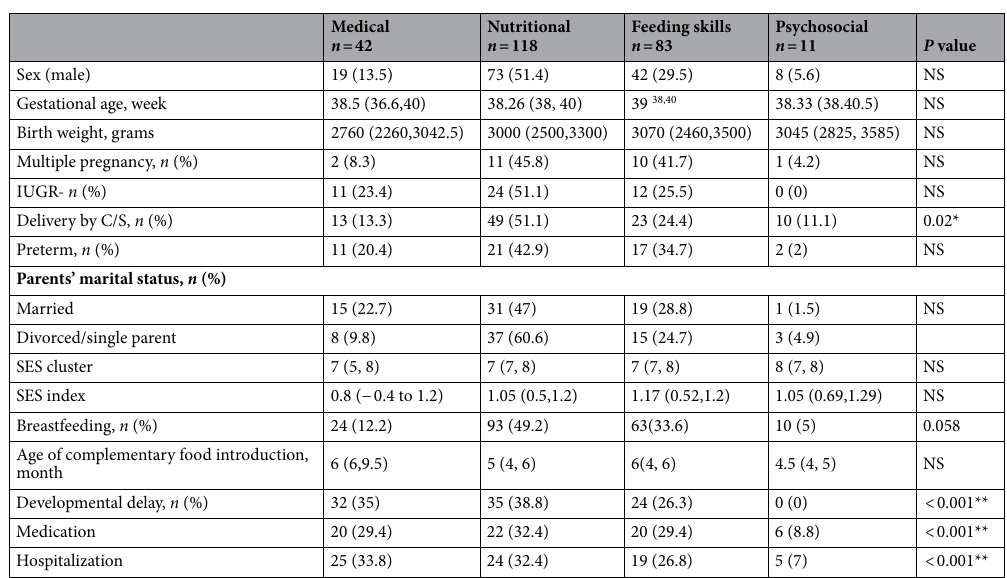
Table 3. Factors associated with feeding disorders according to feeding disorder type. The data are expressed as median and interquartile range for continuous variables and n (%) for categorical variables. IUGR intrauterine growth restriction, C/S cesarean section, SEP socioeconomic position. *Difference between psychosocial dysfunction and three other groups. **Difference between medical dysfunction and three other